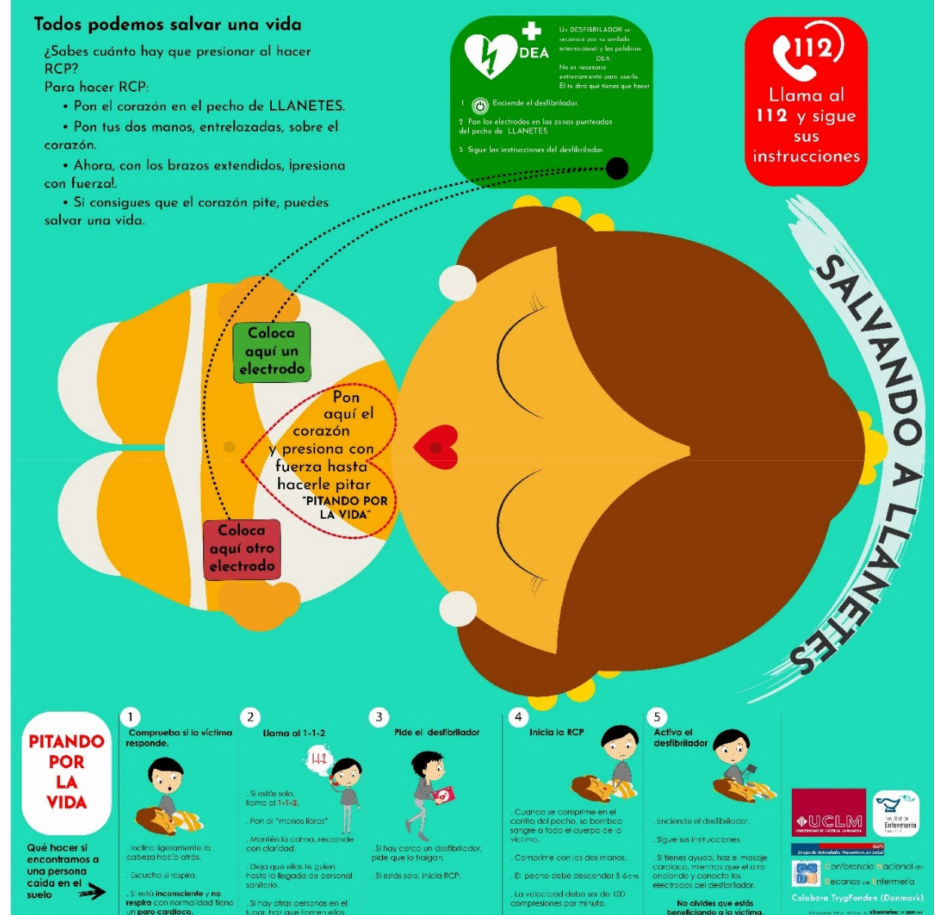
Figure 2. Auditory feedback device base for “Salvando a Llanetes ®